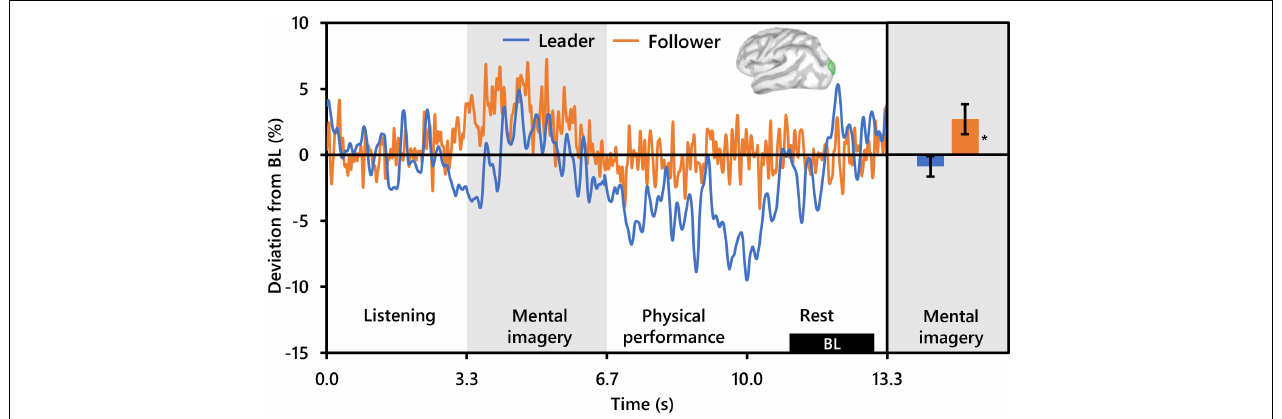
FIGURE 6 | Effect of social role on occipital beta activity ( N = 20). The time-series waveforms (left) show overall mean beta (15–29 Hz) activity in the left significant cluster overlapping the lateral occipital cortex (see displayed cortical map) across one communication epoch for Leaders and Followers separately and temporally aligned to facilitate visual comparison. The histogram (right) shows representative overall mean activity over the mental imagery period in the same cluster for each role. BL, baseline period. Error bars are standard error. Asterisk indicates significant differences from 0 based on single-sample t